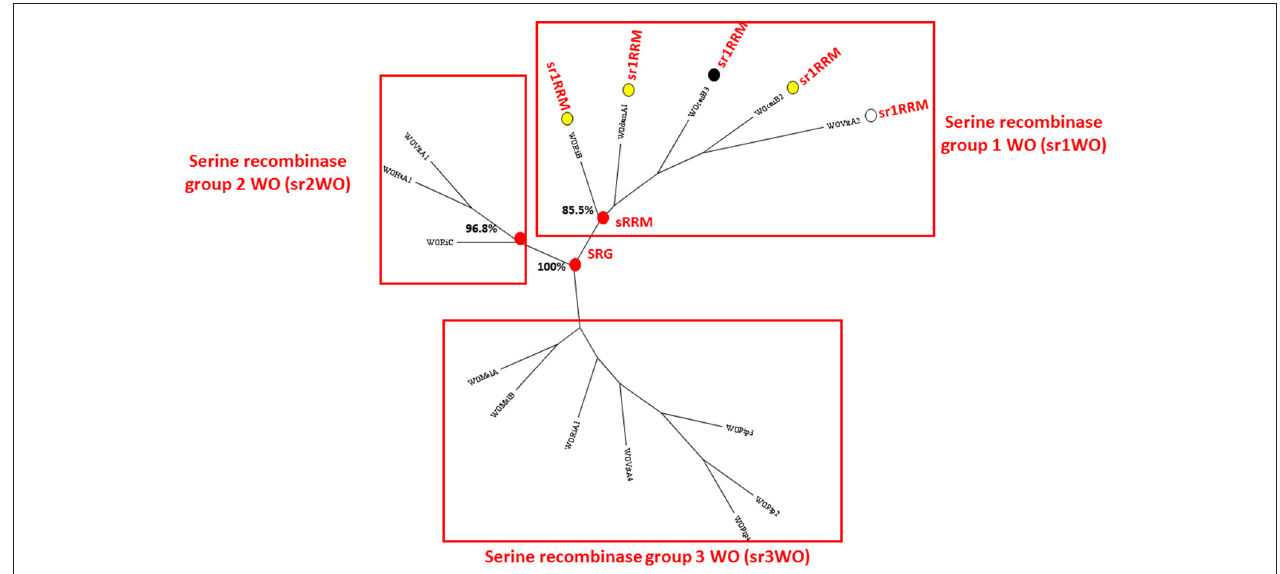
FIGURE 1 | Maximum likelihood consensus tree constructed from an alignment of Wolbachia phage recombinase amino acid sequences. Three bootstrap-supported sequence clusters (labeled sr1WO-sr3WO) recovered in the analysis of Kent et al. (2011a) and Wang et al. (2013) were recovered in this analysis and are indicated. All the WOs known to have the structural group 1 serine recombinase replication module (sr1RRM) can be seen to occur in the sr1WO group. Sr1WO group recombinases are marked with a circle. When these circles are colored in yellow, the phage is known to occur adjacent to the FtsZ cell-division gene, white coloring indicates that the phage’s genomic location is unknown and black is used to indicate that the phage does not appear to be located close to the FtsZ gene. The recombinase amino acid sequences are provided in Supplementary File